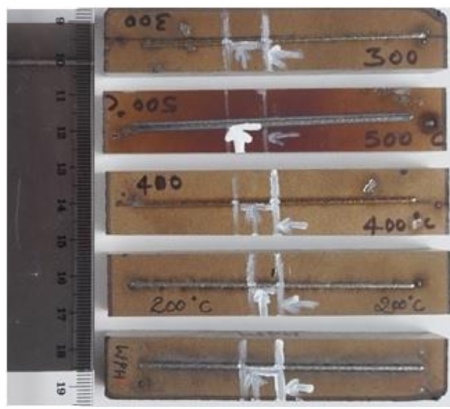
Figure 3. Single-track deposition on deferent base plate preheating temperature.